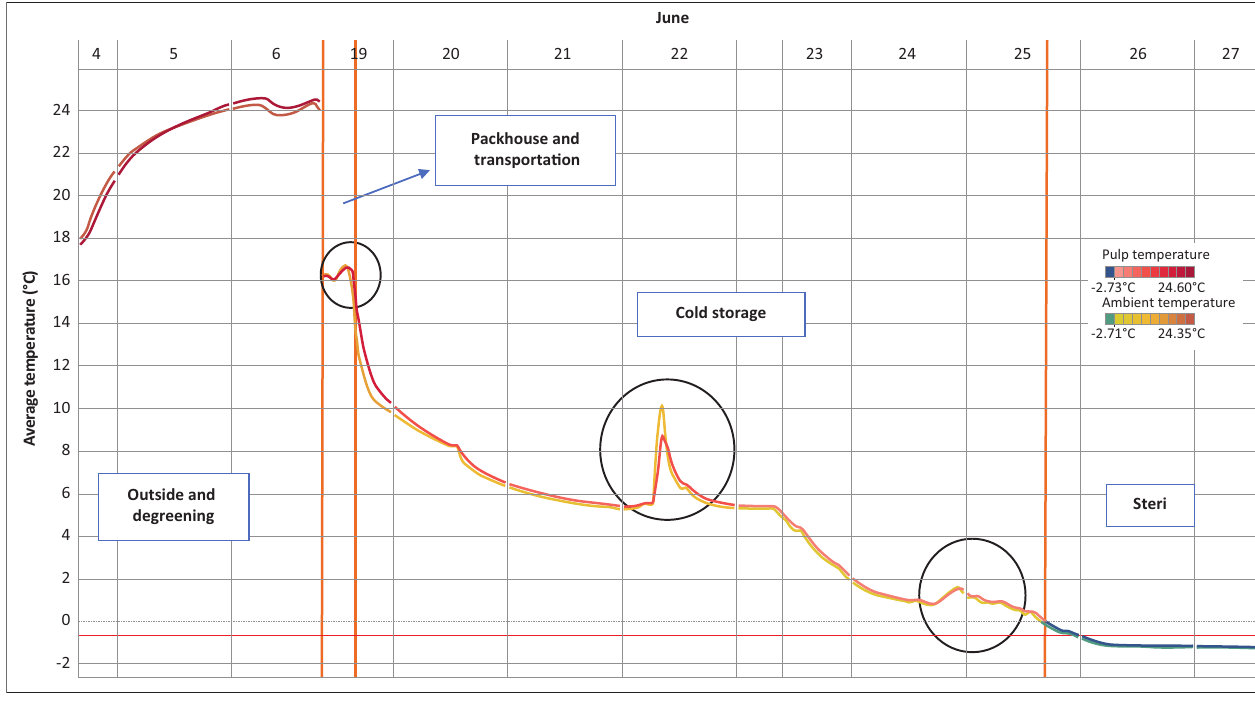
FIGURE 5: Time-series line graph of clementines load one: Pulp and ambient temperature.